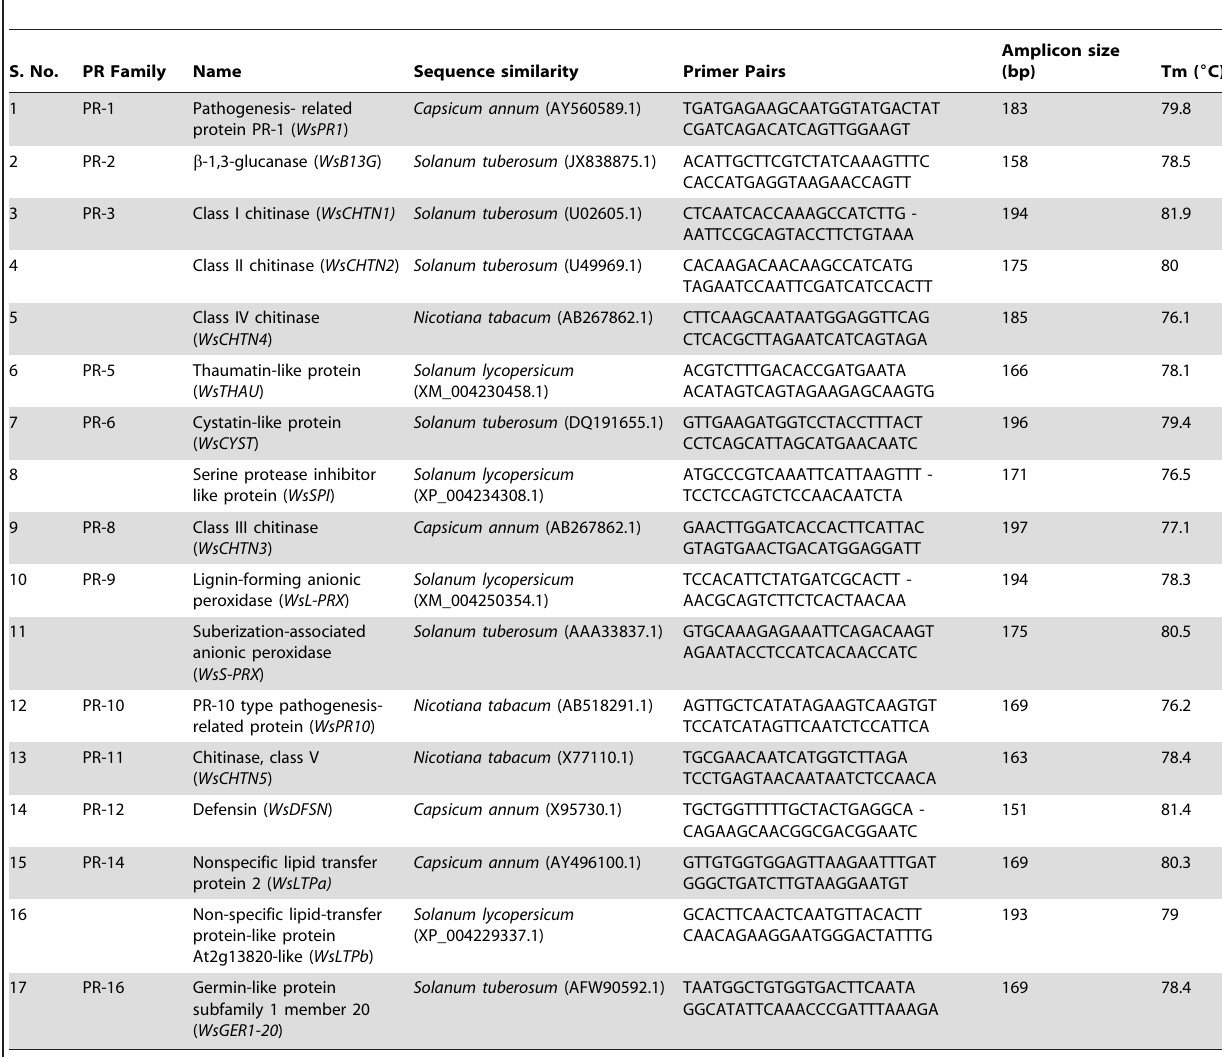
Table 2. Details of primer pairs and amplicon size of pathogenesis - related genes used for expression profiling during SA